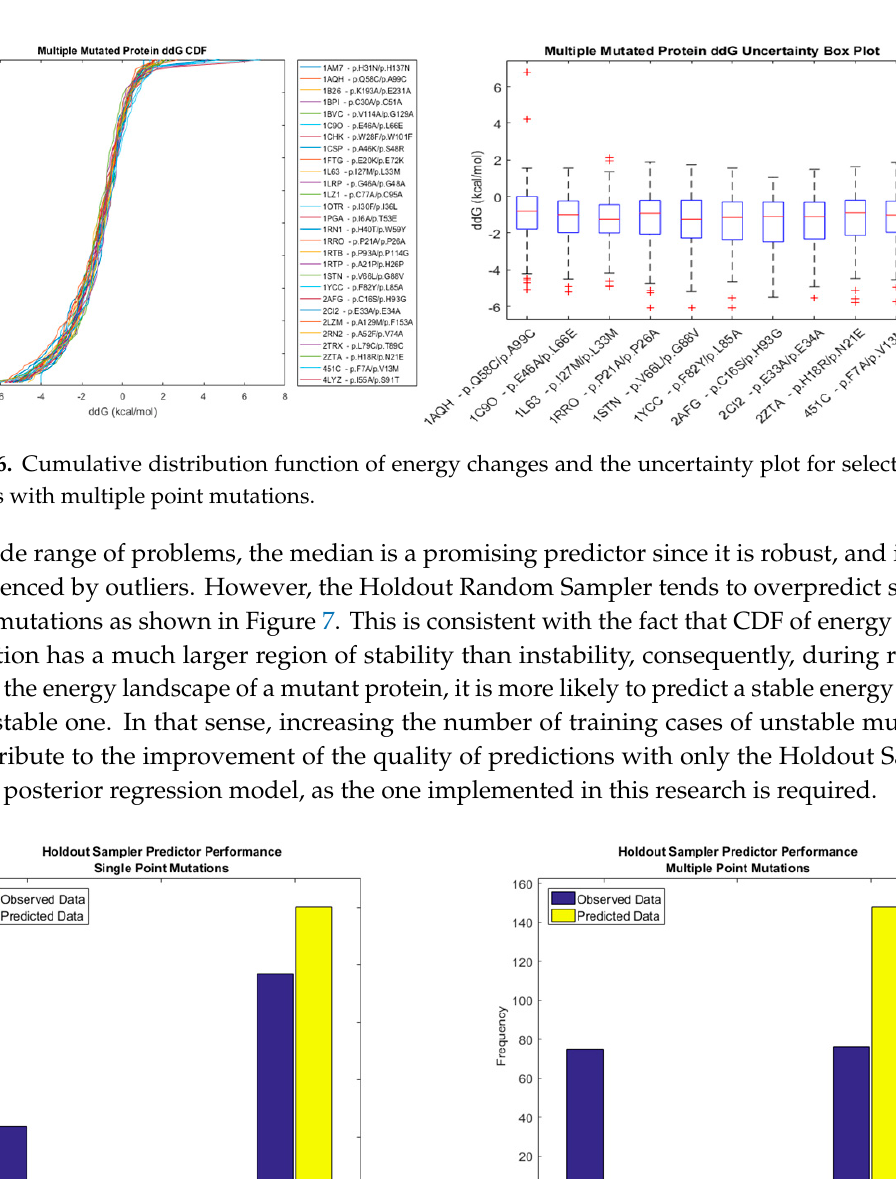
Figure 5. Cumulative distribution function of energy changes and the uncertainty plot for selected proteins with a single point mutation.